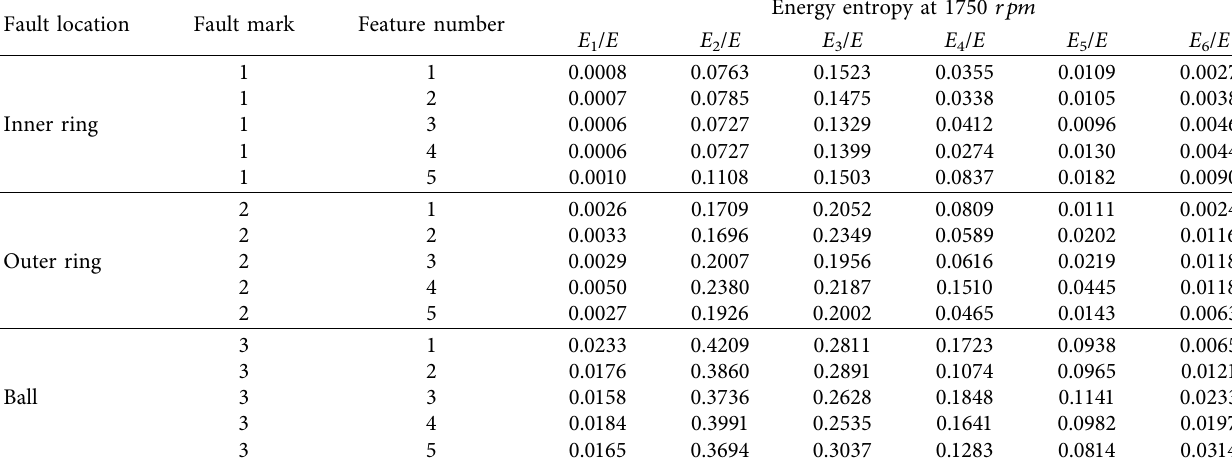
Table 2: Energy entropy at 1750 rpm.